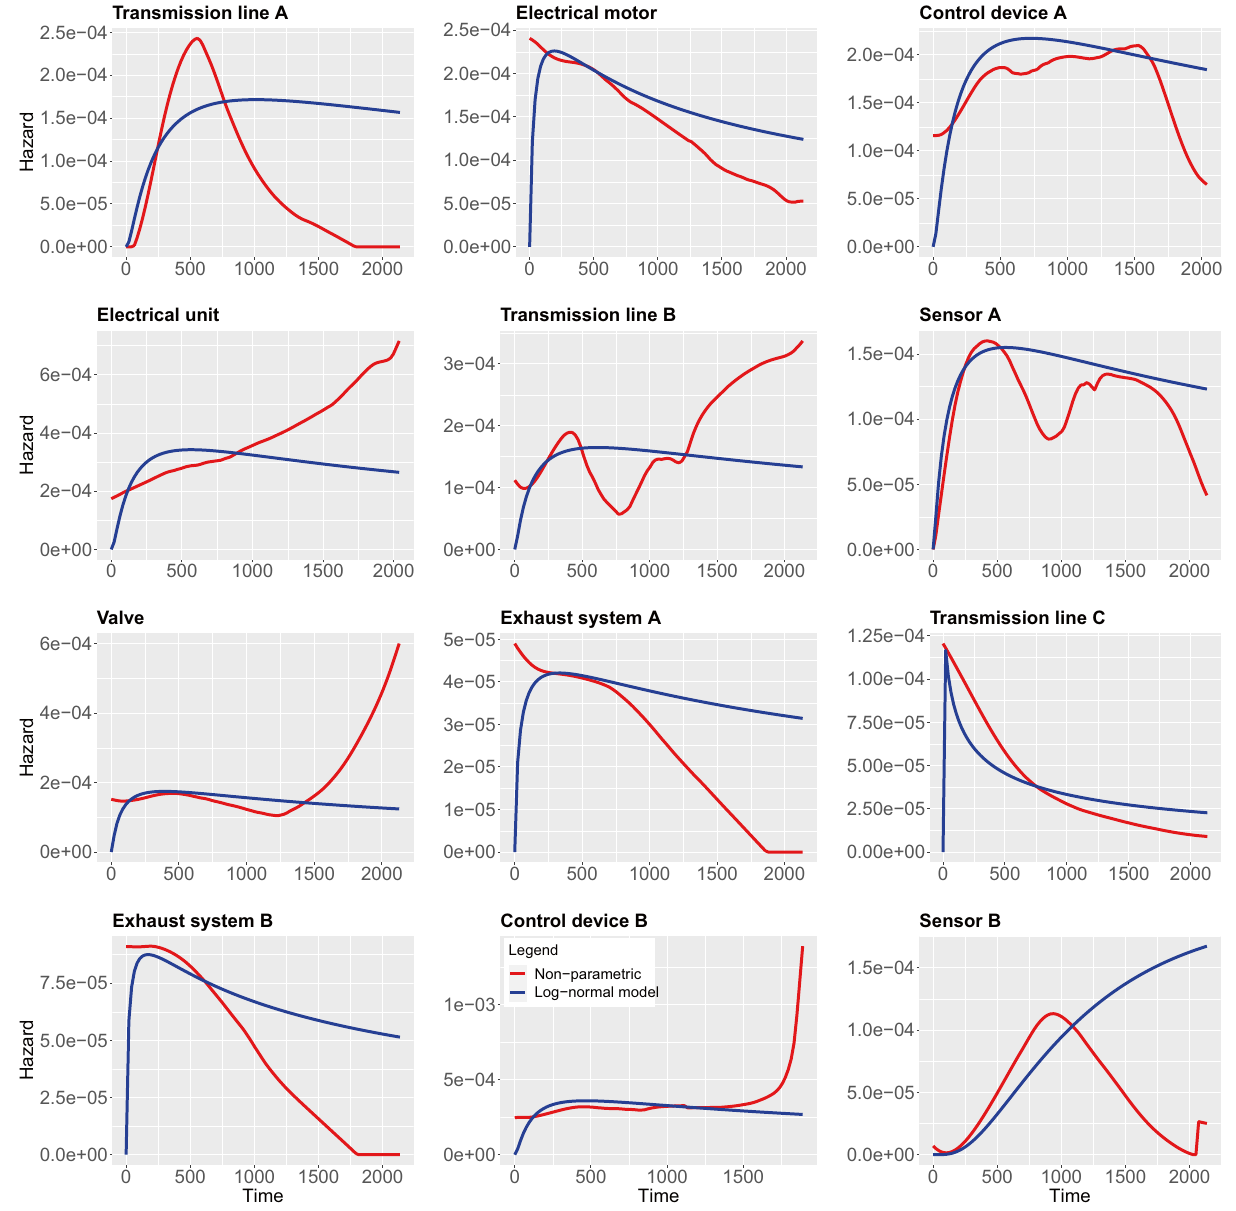
Figure 10. Log-normal model hazard. Blue curve indicates Log-normal model hazard and red curve represents non-parametric kernel-estimator